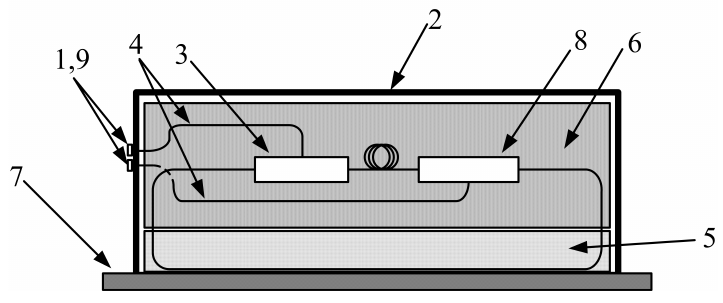
Figure 4. Longitudinal section of the sensory unit